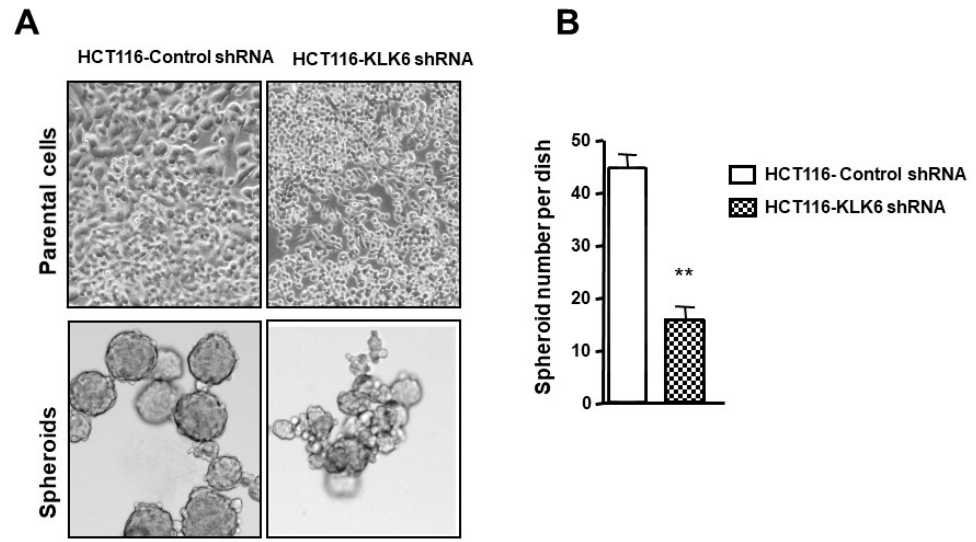
Figure 7. Effect of KLK6 silencing on colon cancer spheroid formation. Spheres were generated by growing cells at a clonal density of 1000 cells/mL in neural crest cells culture conditions as described in Material and Methods. Cells were dispensed in low-adherent plates and medium was changed twice a week. Spheres were allowed to grow over the course of 12 days. Spheres were counted and measured every 2–3 days under the microscope. ( A ) Upper panel: KLK6 silencing results in altered cell morphology. Lower panel: representative images of spheroids formed by HCT116-KLK6 shRNA and HCT116-control shRNA cells randomly taken at day 6 after subculture. ( B ) Spheroids number formed by HCT116-KLK6 shRNA and HCT116-control shRNA cells. Data are shown as mean ± SEM of three independent experiments each performed in duplicate. ** p < 0.01.